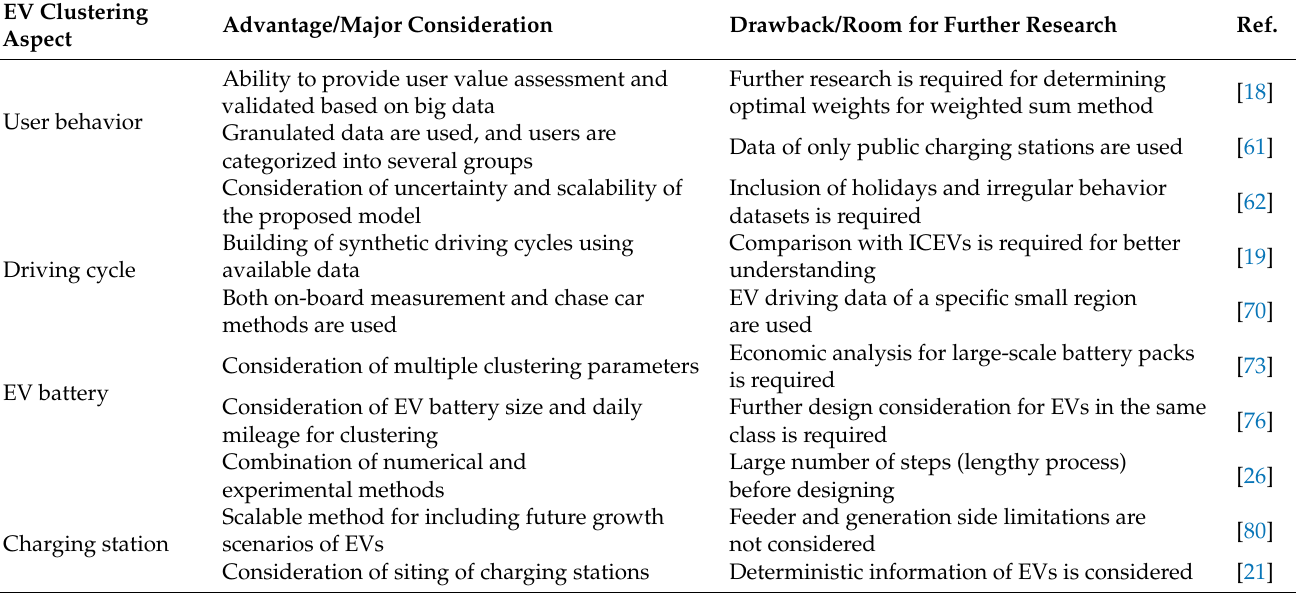
Table 7. Summary of representative papers from each EV clustering